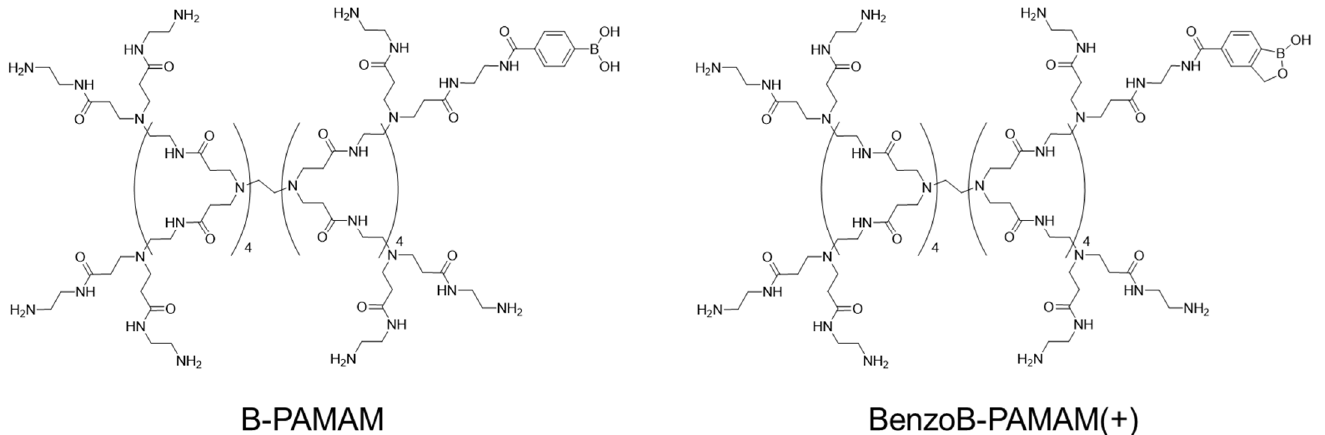
Figure 1. Schematic image of selective bacterial recognition by boronic acid-modified PAMAM dendrimer probes.